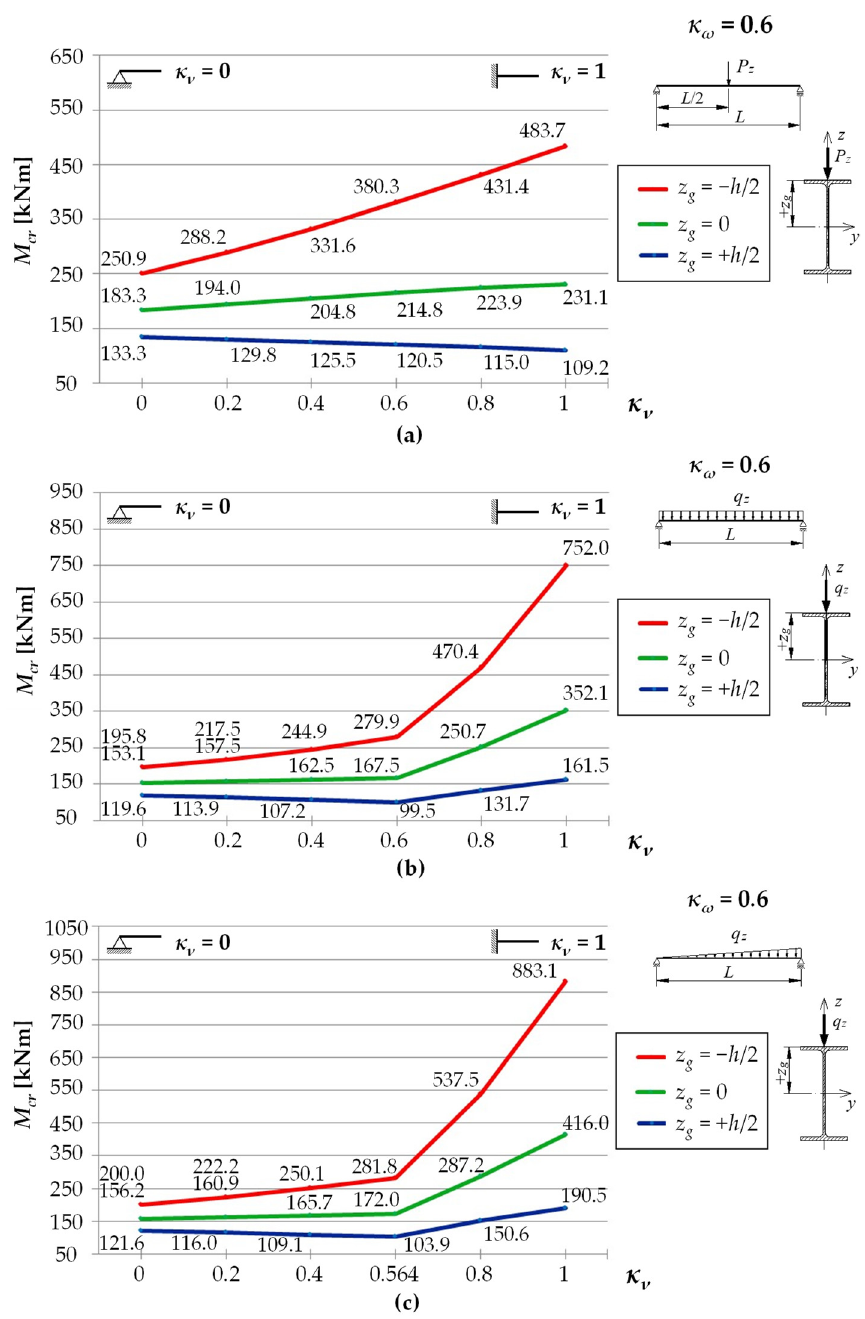
Figure 3. Trends in M cr variation according to LTBeamN software as a function of the fixity index κ ν : ( a ) beam under the concentrated force load at the midspan, ( b ) beam under a uniform load, ( c ) beam under a triangularly distributed load.